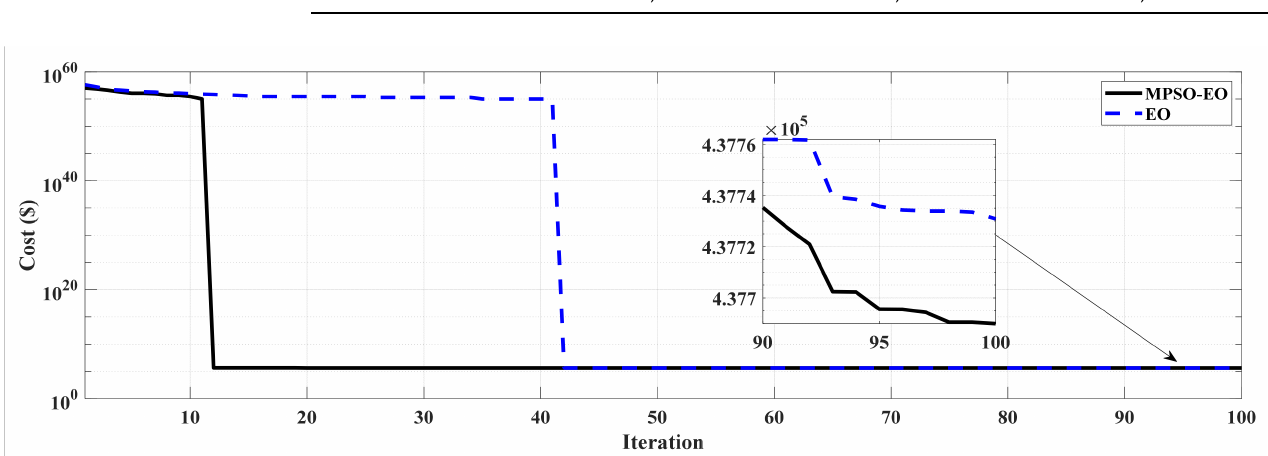
Figure 7. Comparison of convergence characteristics between MPSO-EO and EO for the 10-unit system (test system